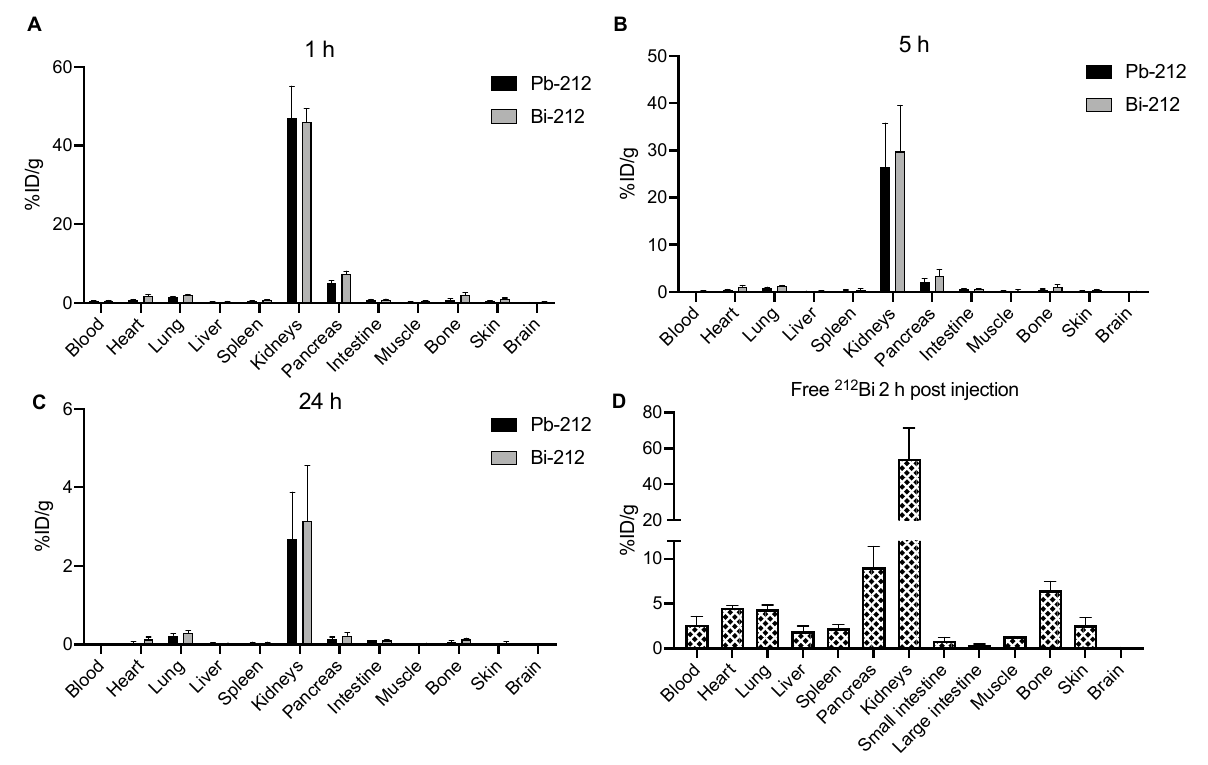
Figure 5. In vivo biodistribution of [ 212 Pb]Pb-PSC-PEG-T in naïve tumor free female CD-1 Elite mice at ( A ) 1 h, ( B ) 4 h, and ( C ) 24 h post injection of 74 kBq [ 212 Pb]Pb-PSC-PEG-T via tail vein; [ 212 Pb]Pb- PSC-PEG-T and [ 212 Bi]Bi-PSC-PEG-T were co-injected together when 212 Bi had reached equilibrium with 212 Pb. In addition, biodistribution of ( D ) free 212 Bi was also determined at 2 h post injection of 74 kBq 212 Bi. Radioactivity of 212 Pb and 212 Bi in organs of interest was measured on an automated gamma counter using 238 keV and 583 keV gamma peaks, respectively. Data presented as mean %ID/g ± SD (n = 3).